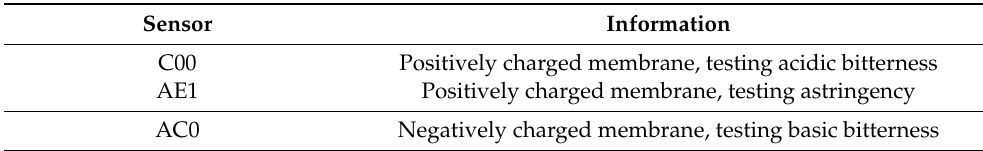
Table 5. Different lipid membrane sensors used in the E-tongue testing. Sensor Information C00 Positively charged membrane, testing acidic bitterness AE1 AC0 Negatively charged membrane, testing basic